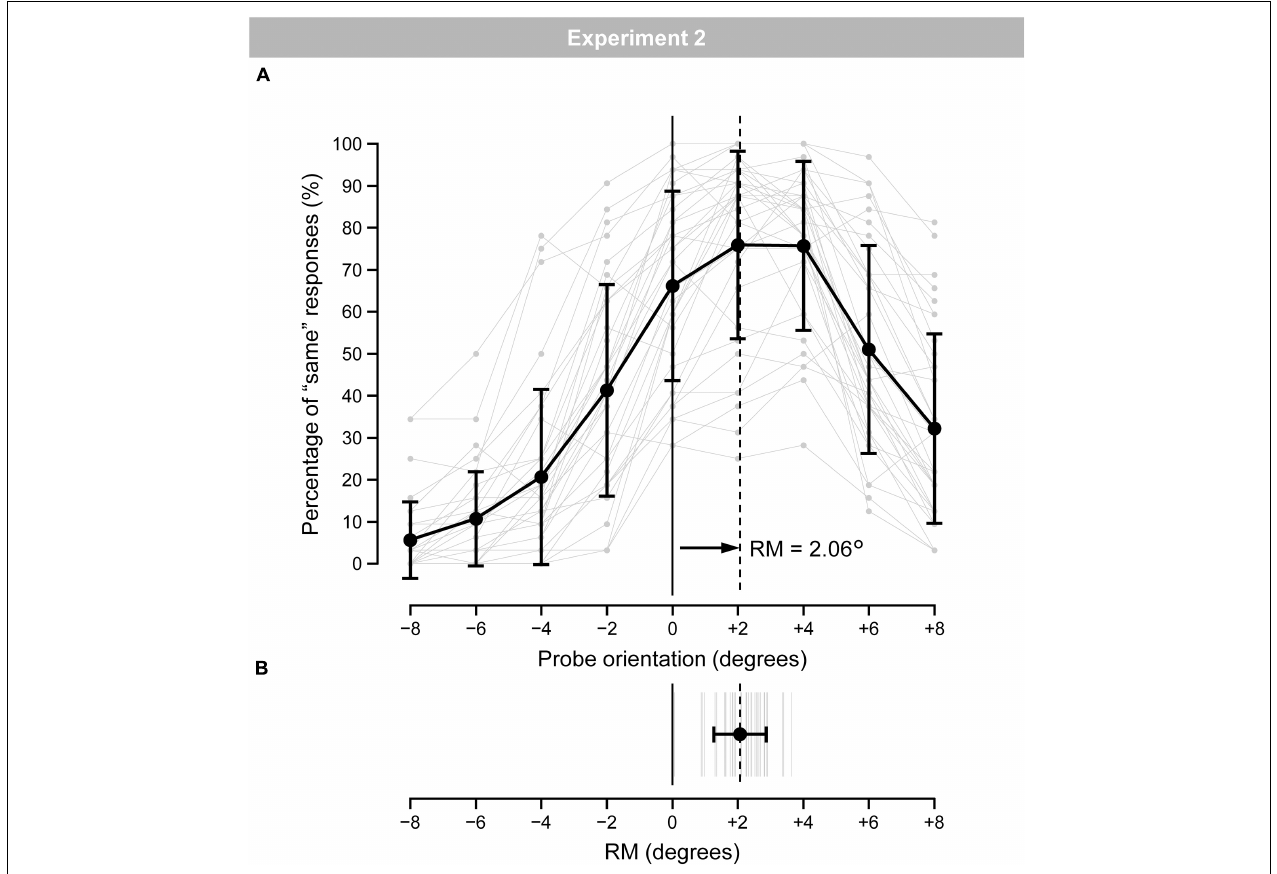
FIGURE 6 | (A) Mean (black) and individual (gray) percentages of “same” responses for the nine probe-orientation categories in the regular trials. Error bars indicate SD . (B) Mean (black) and individual (gray) magnitudes of RM. Error bars indicate SD